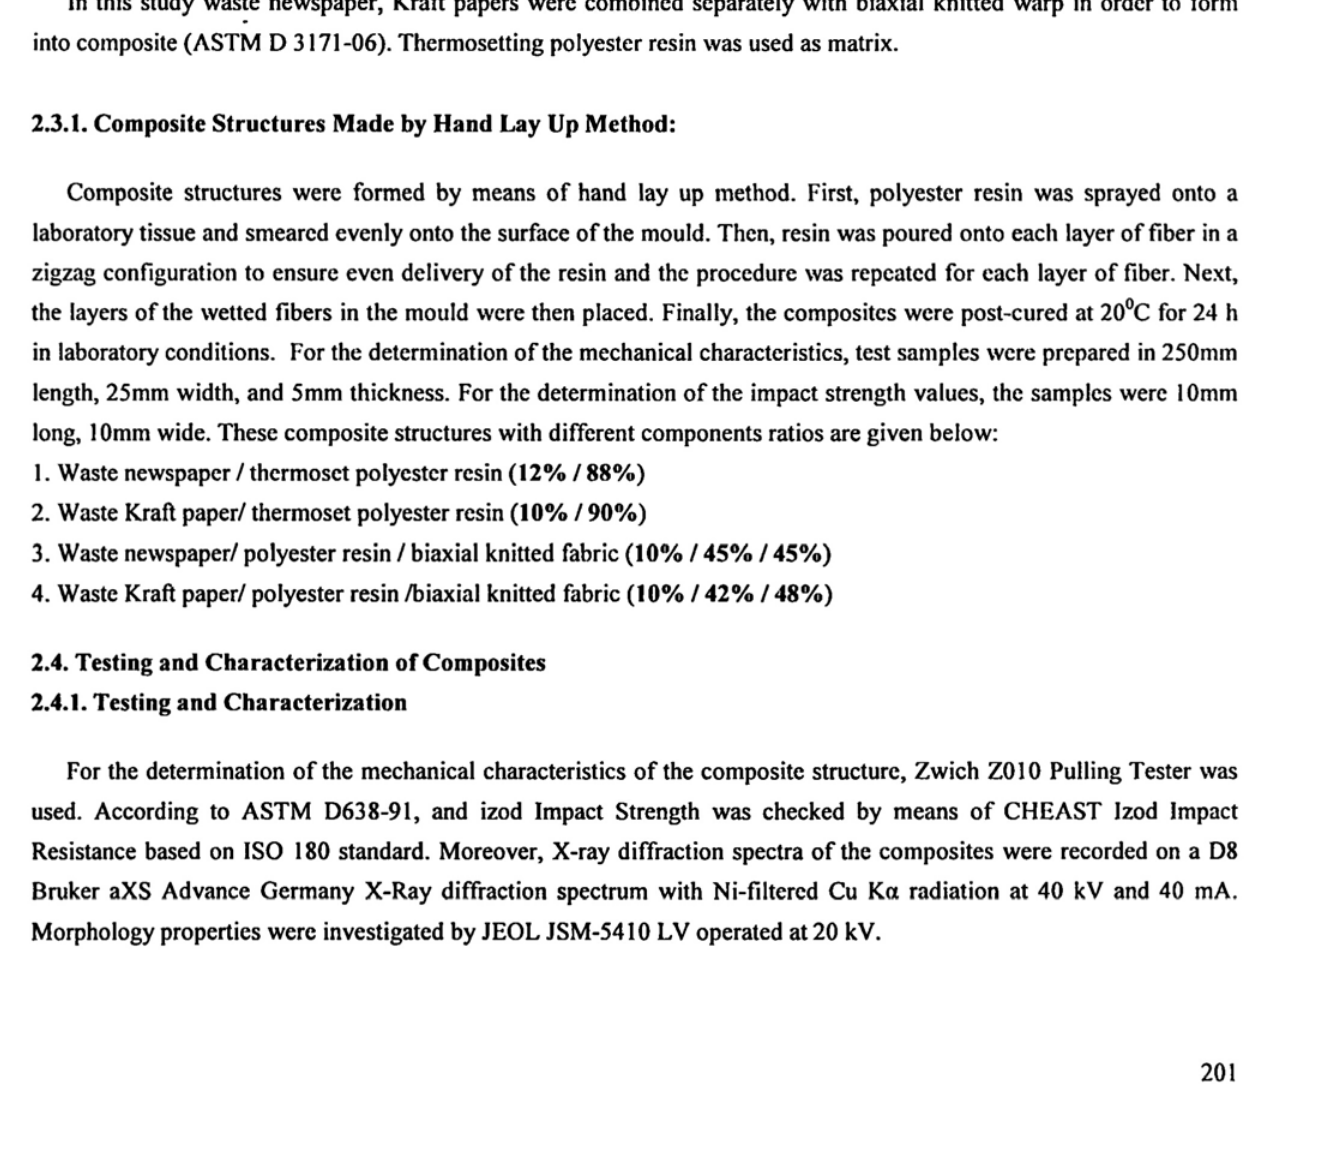
Fig. 2. Picture of sheet form of (a) Newspapers and (b) Waste Kraft